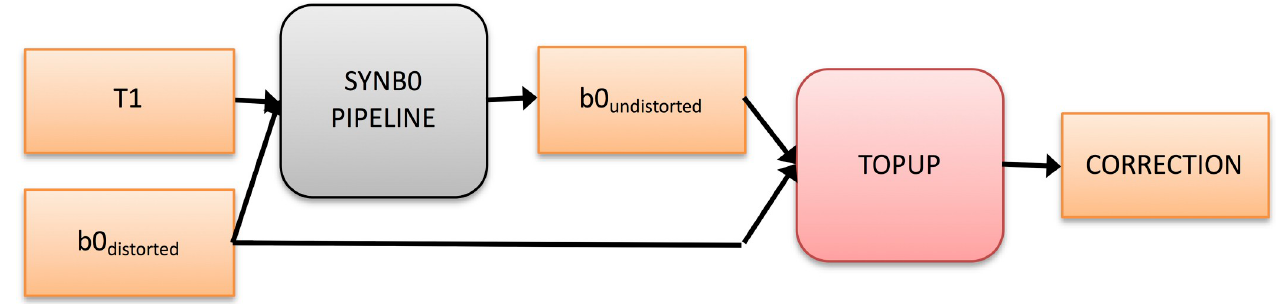
Fig 1. Overall pipeline. The goal is to generate an undistorted b0 from a single blip (distorted) b0 and an anatomical T1 image through a deep learning approach. The undistorted image can then be concatenated with the distorted b0 and run through FSL’s topup using a simulated infinite PE-bandwidth. This final correction can be used with FSL’s eddy (or another eddy current modeling tool) to provide a full correction for diffusion data given only a single phase encoding. Note that the proposed algorithm does not seek to model/correct eddy current effects.